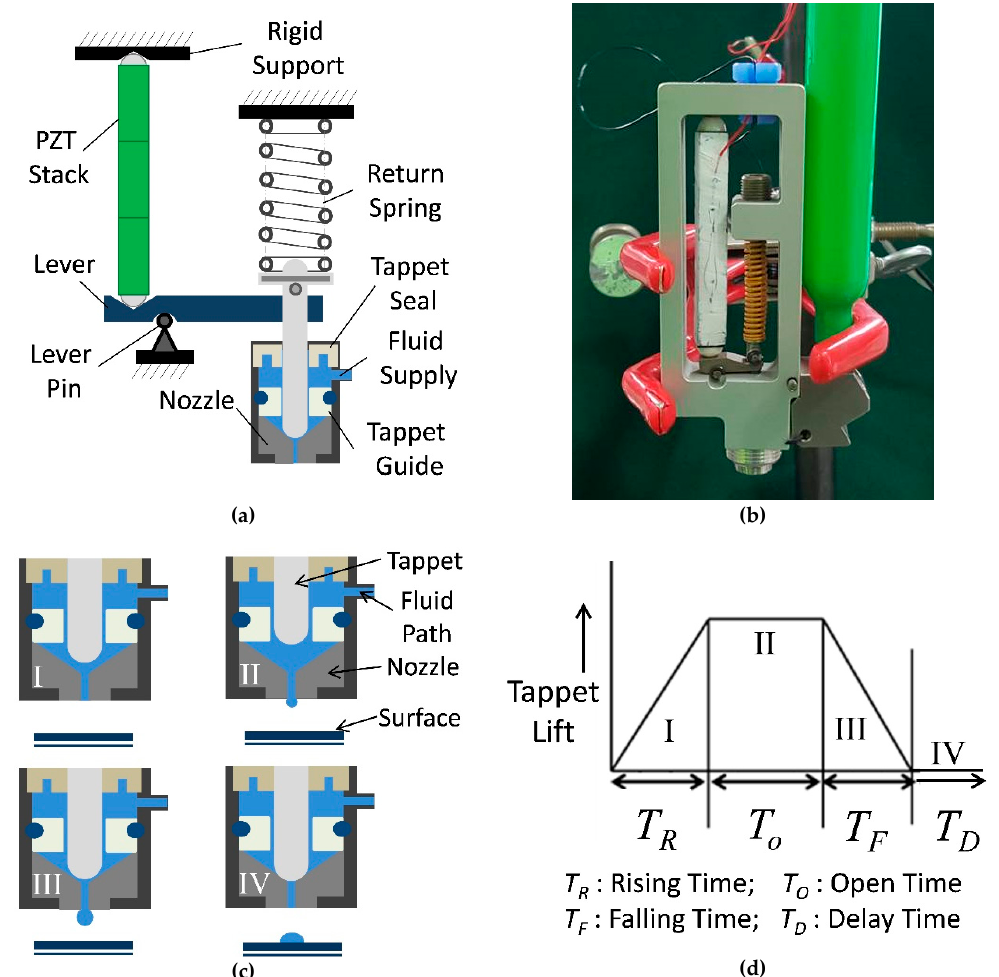
Figure 2. Configuration of the needle-type piezo-driven liquid jet dispenser and its dispensing mechanism ( a ) jet dispenser model with labelled components; ( b ) fabricated piezo-driven jet dispenser with a liquid syringe; ( c ) needle position with respect to dispenser driving cycle; ( d ) driving cycle for the jet dispenser.